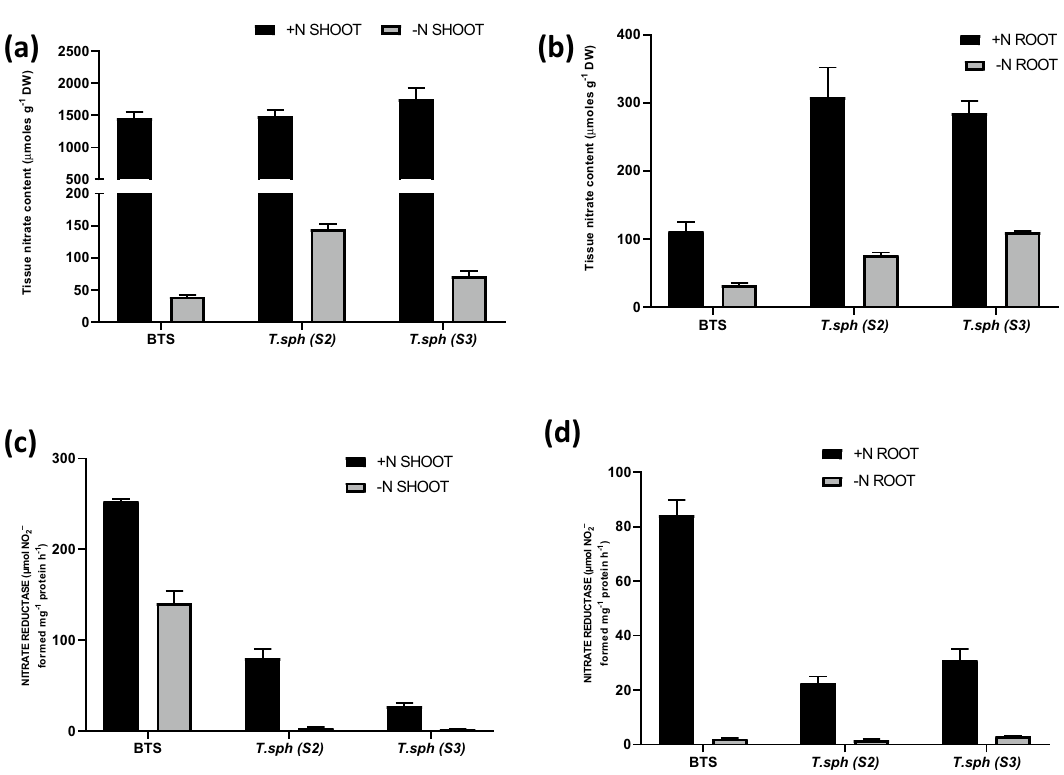
Figure 6. Effect of nitrogen deficient (0.05 mM nitrate, N−) and nitrogen sufficient (7.5 mM nitrate, N+) conditions on tissue nitrate content ( a , b ) and nitrate reductase (NR) activity ( c , d ) of thirty days old seedlings of wheat genotypes grown under hydroponic